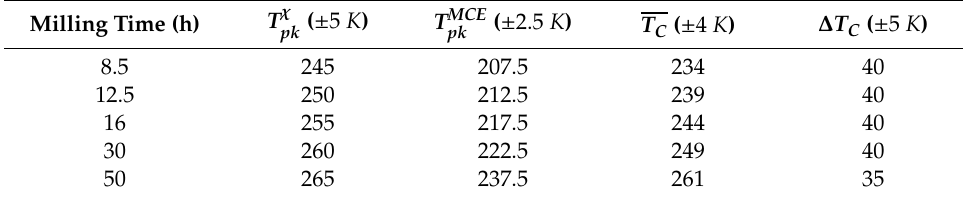
Table 2. Experimental values of the temperatures corresponding to the peaks of paramagnetic χ susceptibility, T , and the maximum magnetocaloric e ff ect, T MCE pk Curie temperature, T C , and the width of the distribution, ∆ T C , obtained by Equations (4) and (5) for di ff erent times of